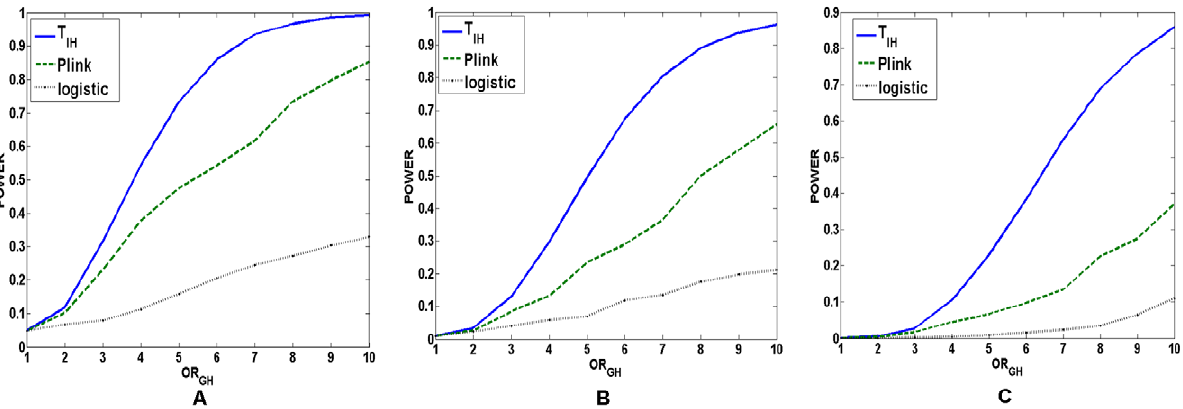
Figure 2. Power of the statistics for testing interaction between two linked loci under recessive disease model. (A) The power of the test statistic T IH , the ‘‘fast-epistasis’’ in PLINK and logistic regression analysis for testing interaction between two linked loci as a function of traditional odds-ratio OR GH under a two-locus recessive | recessive disease model, where the number of individuals in both the case and control groups is 2,000, the significance level is 0.05, and the odds-ratios at two loci were OR G ~ OR H ~ 1 . (B) The power of the test statistic T IH , the ‘‘fast- epistasis’’ in PLINK and logistic regression analysis for testing interaction between two linked loci as a function of traditional odds-ratio OR GH under a two-locus recessive | recessive disease model, where the number of individuals in both the case and control groups is 2,000, the significance level is 0.01, and the odds-ratios at two loci were OR G ~ OR H ~ 1 . (C) The power of the test statistic T IH , the ‘‘fast-epistasis’’ in PLINK and logistic regression analysis for testing interaction between two linked loci as a function of traditional odds-ratio OR GH under a two-locus recessive | recessive disease model, where the number of individuals in both the case and control groups is 2,000, the significance level is 0.001, and the odds-ratios at two loci were OR G ~ OR H ~ 1 .